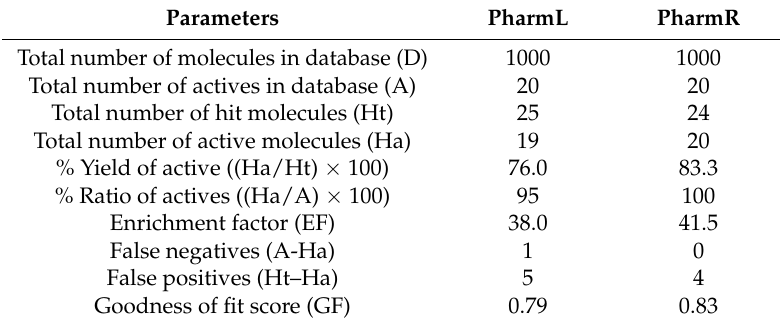
Table 6. Decoy set validation of both the pharmacophore